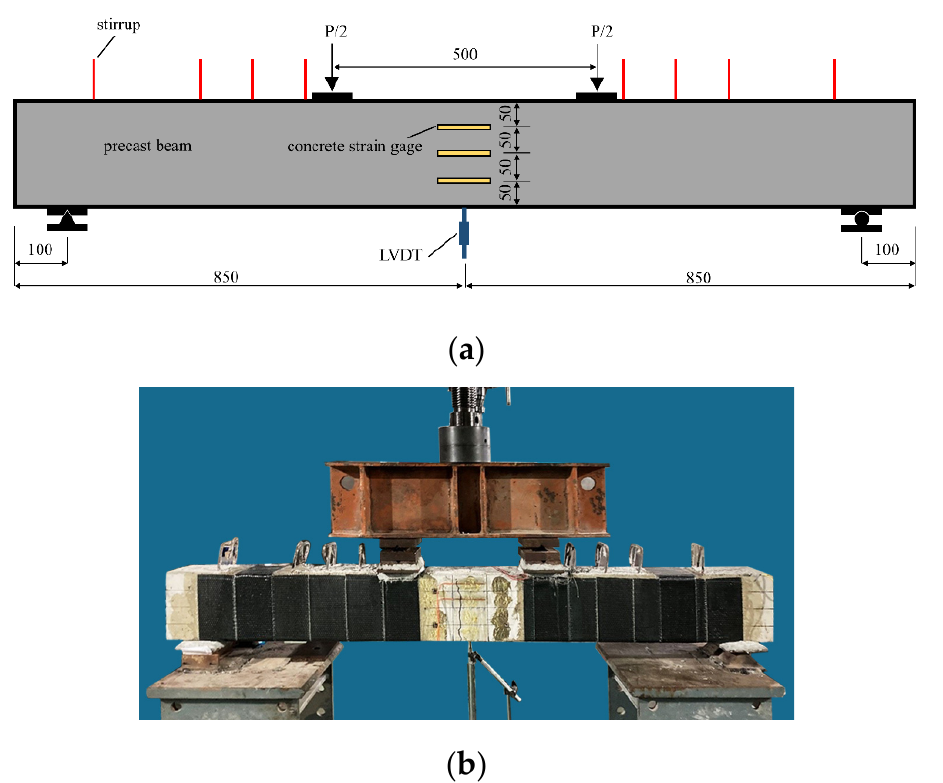
Figure 7. The fatigue loading of the precast beams: ( a ) a schematic of the fatigue loading test (units: mm) and ( b ) the layout of the fatigue loading test. The fatigue life of the component was 152,355 cycles, and the failure mode was bending failure. Figure 8 plots the evolution curve of the midspan deflection of the beams during the fatigue test.